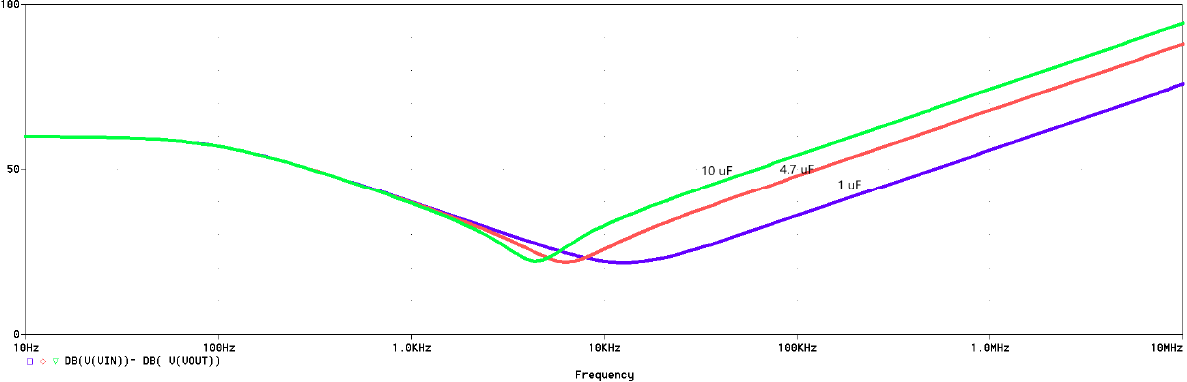
Figure 9. Simulated old PSRR characteristic of the TPS785-Q1 model.